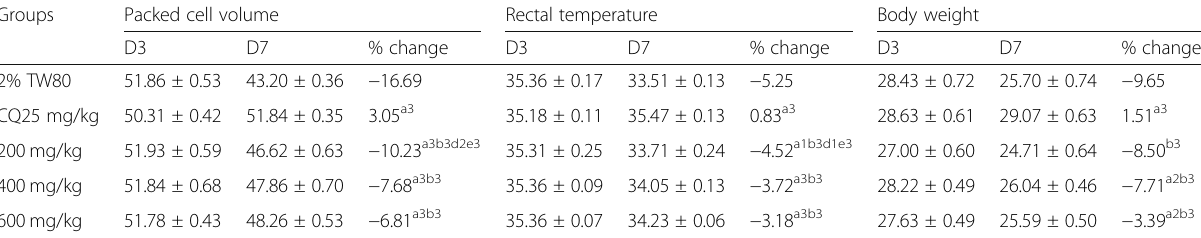
Data are expressed as mean±SEM; n=6; a, compared to negative control; b, to CQ25 mg/kg; c, to 200mg/kg; d, to 400mg/kg; e, to 600mg/kg; 1, p <0.05; 2, p < 0.01; 3, p <0.001; 2% TW80, 2% Tween80; CQ chloroquine, D3 pre-treatment value on day 3, D4 post- treatment value on day 7